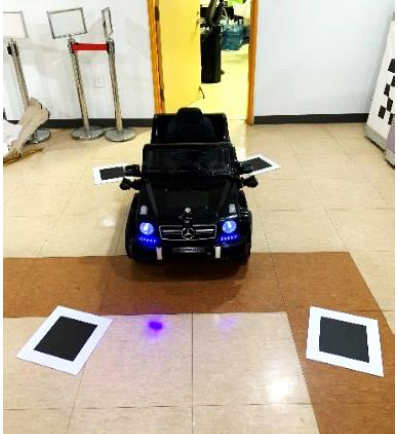
Figure 14. The experimental environment using an electric vehicle for children.